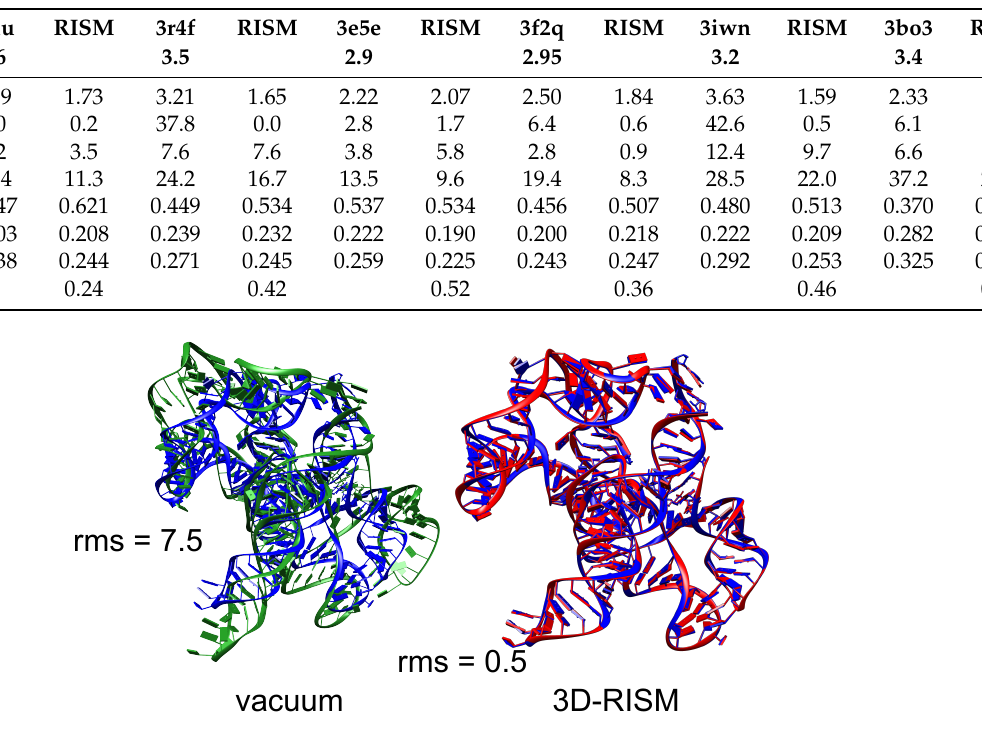
Table 4. Comparison of deposited and 3D-RISM-refined structures. Outliers are in percent; RMS vs deposited is in Å, averaged over all non-heavy atoms.